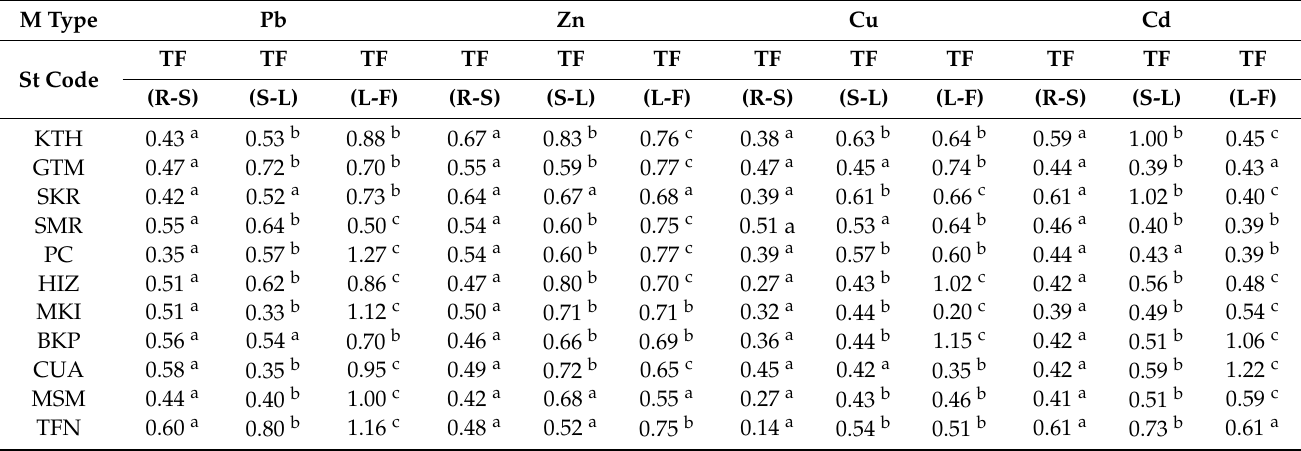
Table 2. Translocation factor of Pb, Zn, Cu, and Cd in X. strumarium growing on different abandoned habitats in Khyber Pakhtunkhwa,